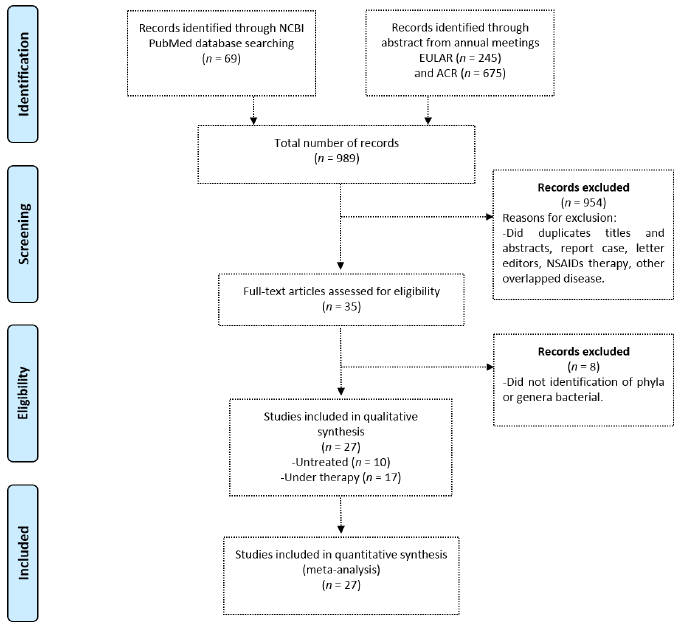
Figure 1. Flowchart illustrating the search results and selection process of journals included in this study, following the Transparent reporting of systematic reviews and meta-analyses (PRISMA)